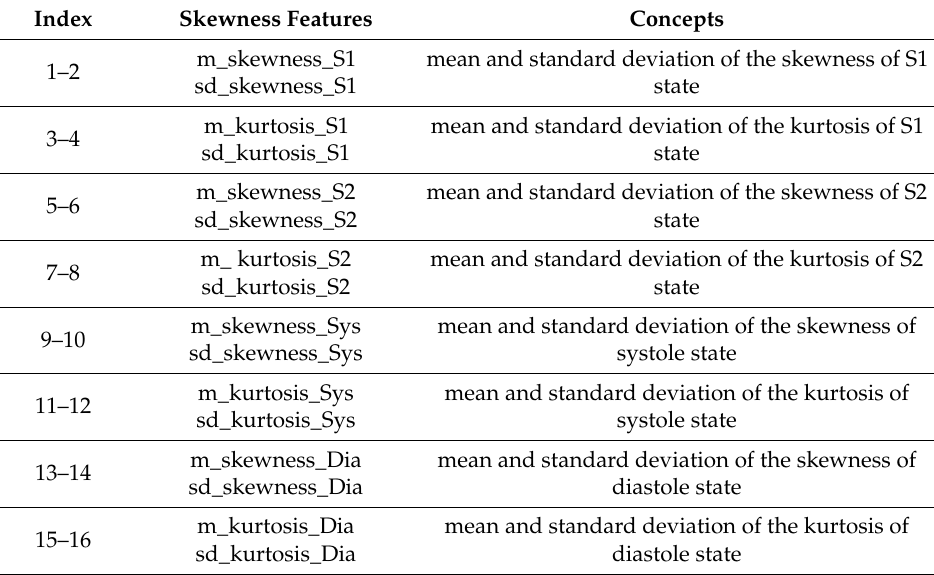
Table A4. The summary of the skewness and kurtosis features extracted from four